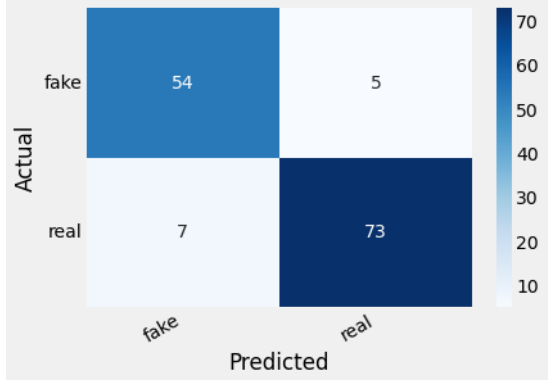
Figure 6. Confusion Matrix of BERT base -CNN-BiGRU in PolitiFact.